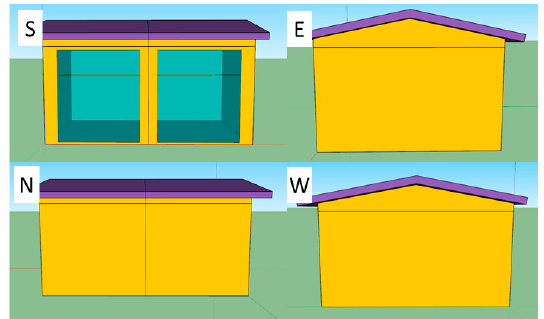
Figure 4. Modeling of testbed.